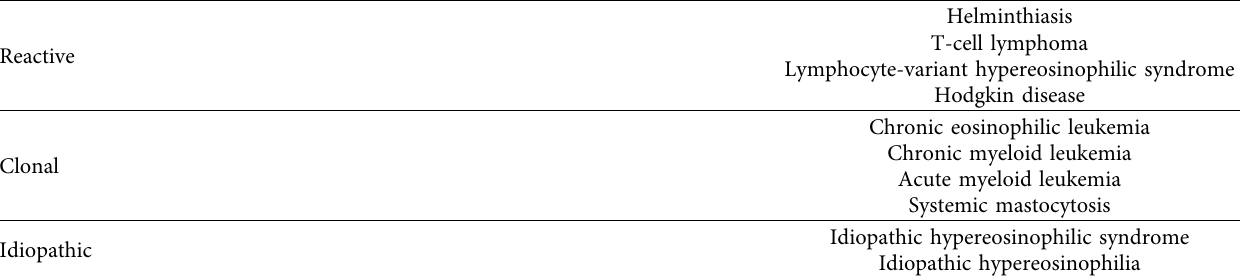
Figure 3: Bone marrow aspirate morphology and FISH result: (a) Bone marrow aspirate showing (i) eosinophilic myelocyte (ii) eosinophilic metamyelocyte (iii) eosinophilic band (iv) normoblast (b) FISH signal pattern at diagnosis indicative of deletion of CHIC2 gene. FISH signal patterns in nuclei having interstitial deletions of the orange probe target (CHIC2) should be observed as one tri-colour fusion and one green/ aqua fusion. (c) FISH signal pattern 3 months post imatinib showing no evidence of CHIC2 Table 2: Diferential diagnoses of hypereosinophilia.